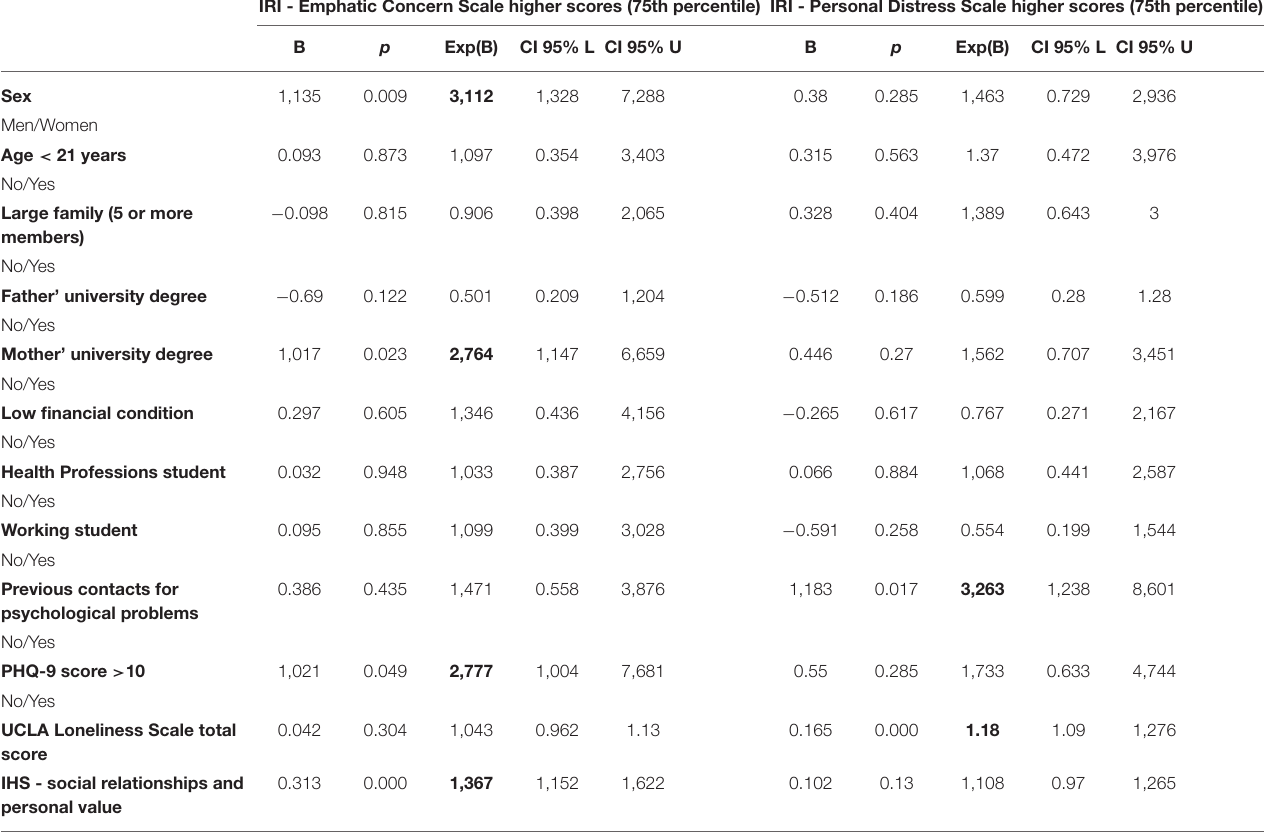
TABLE 6 | Logistic regression analysis for predicting the affective dimensions of empathy as measured by Interpersonal Reactivity Index